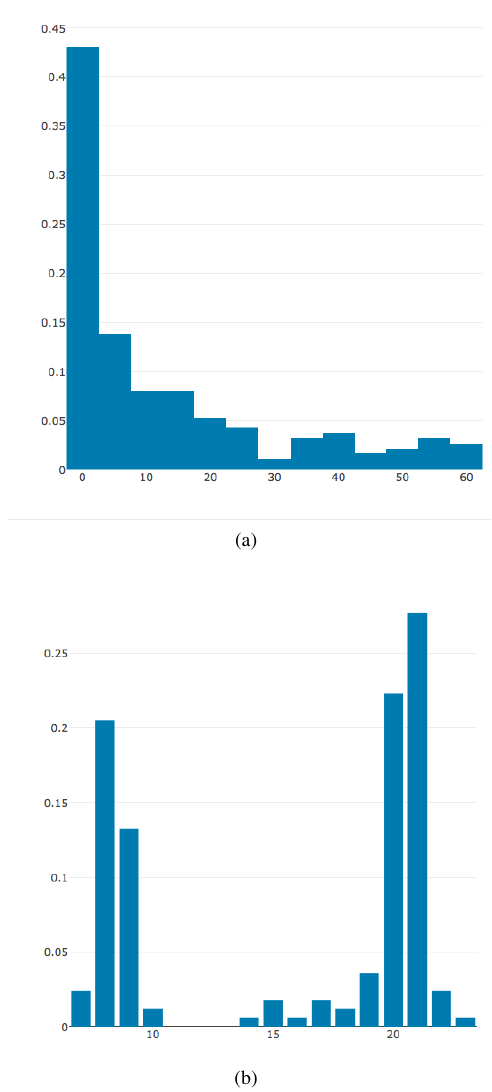
Figure 10. Statistics about the event. Probability of distribution of time spent during the event, hourly